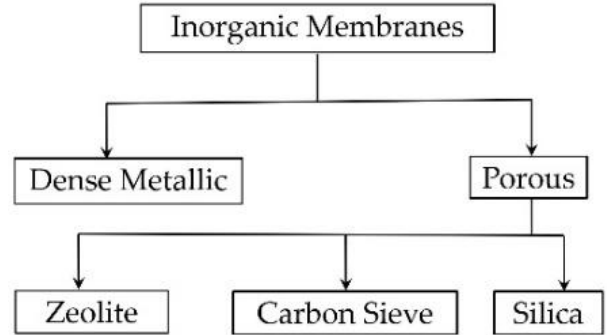
Figure 2. Type of inorganic membranes used for gas